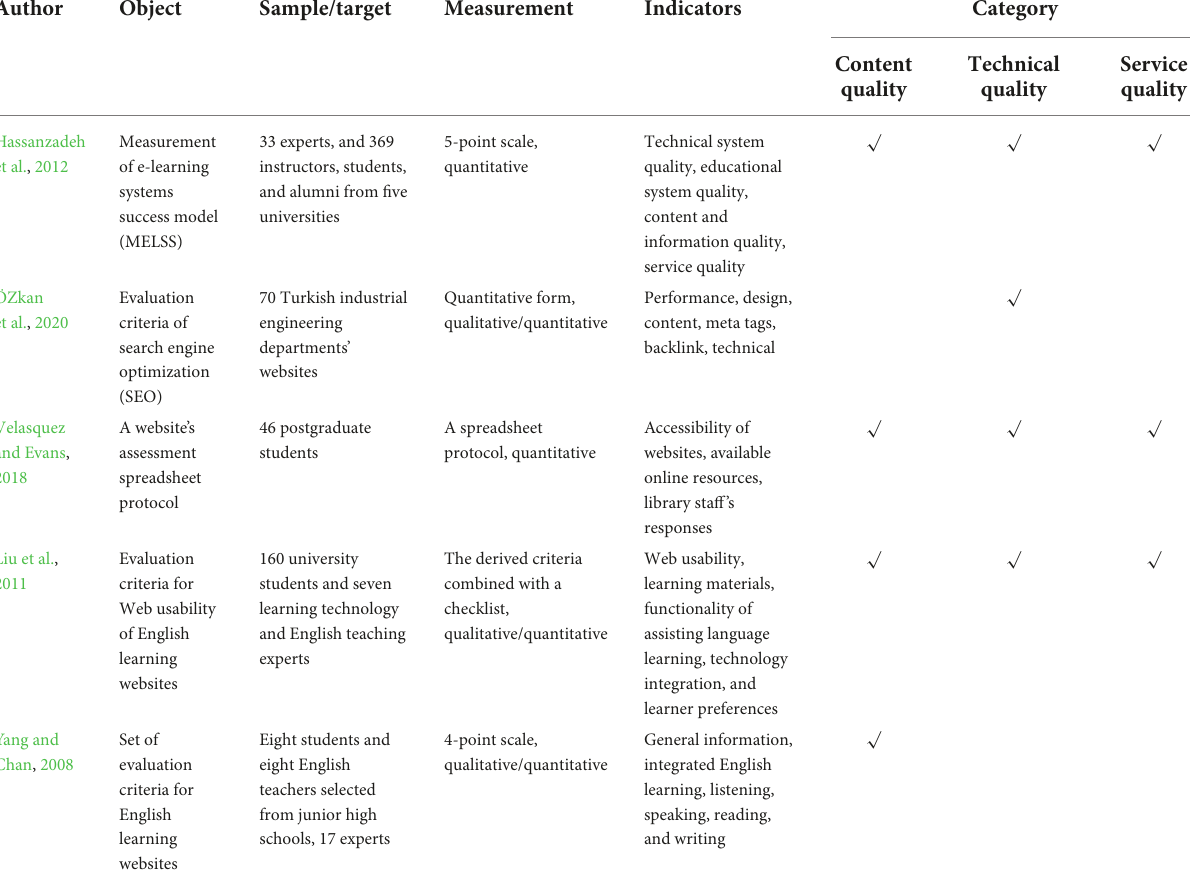
TABLE 1 Main instruments of online learning platforms and